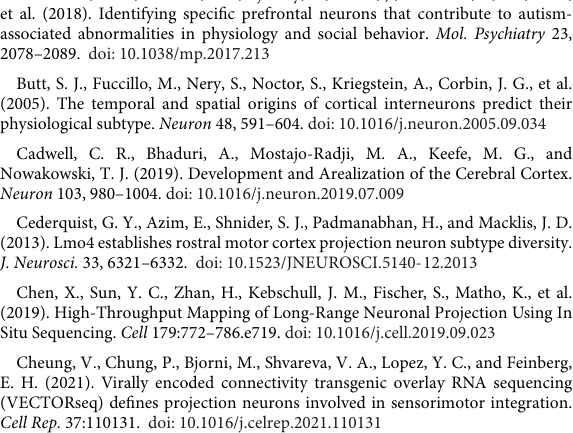
Figure 10E ) or PV and SST cells but not VIP cells across brain regions (no such genes identified). The Violin plots for tenm2 , cenpa , and igf1 were created in Seurat ( Figures 10C–E